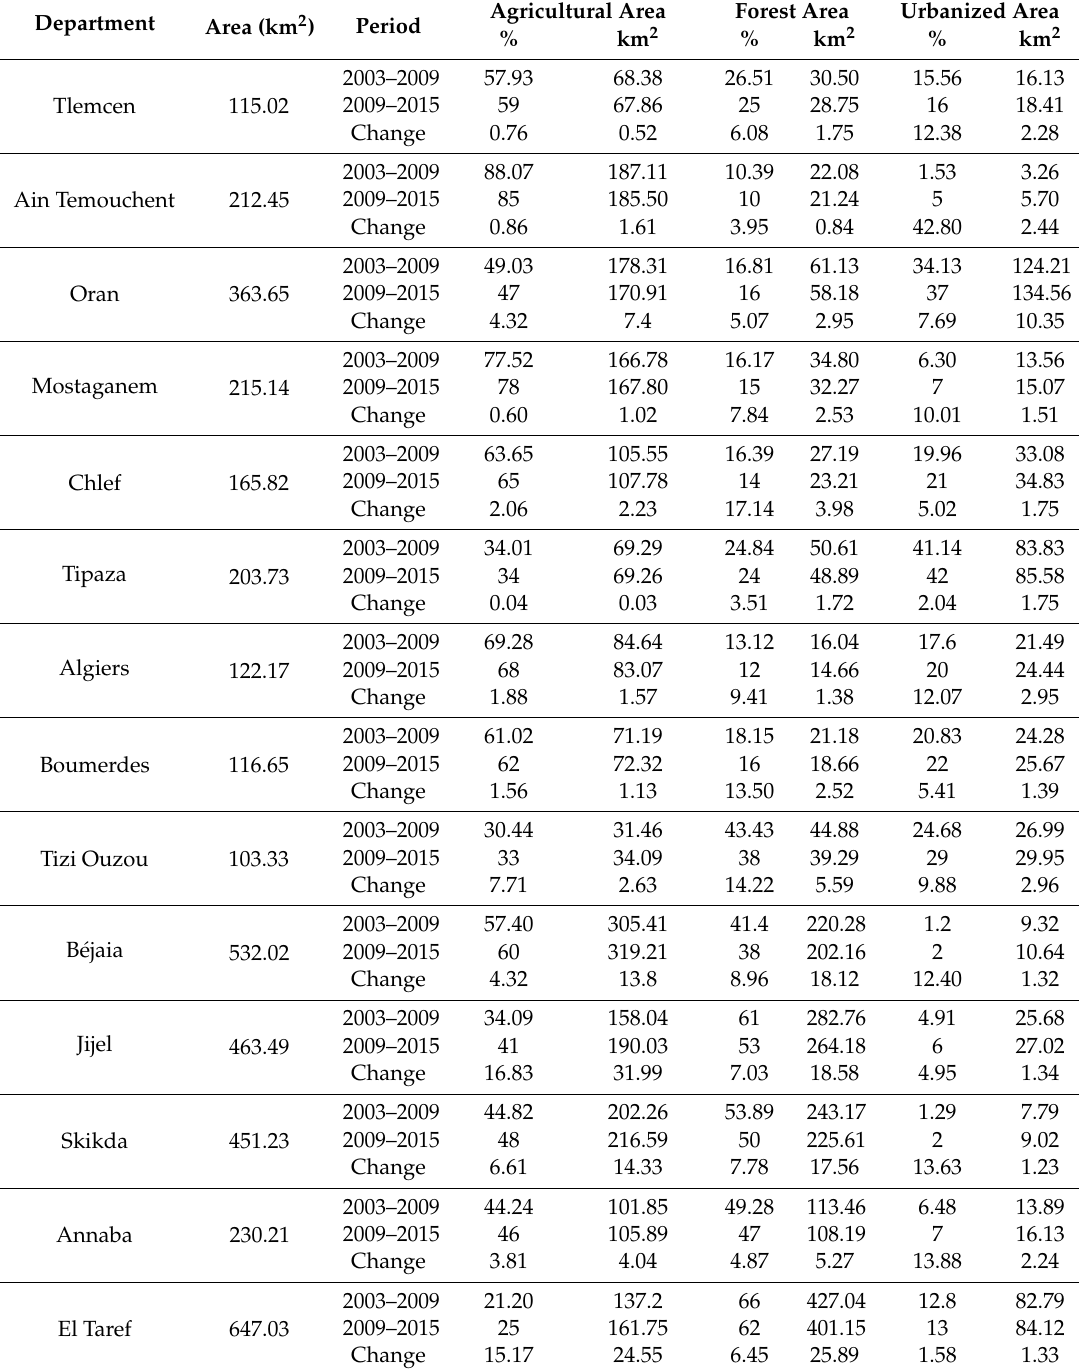
Table 12. Dynamics of land use in the departments of the Algerian coast. Source: National Statistics O ffi ce of